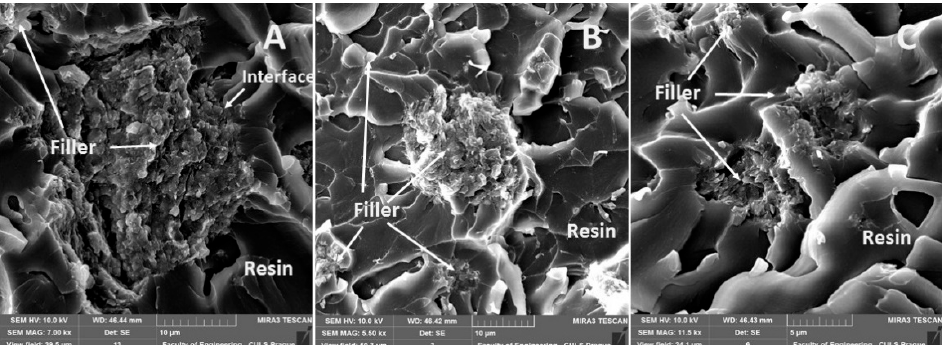
Figure 5. SEM micrographs—static tensile test of composite materials: ( A ) fracture surface of adhesive E5/TFF/100:26/ZR-2 (mag 7.0k×), ( B ) fracture surface of adhesive E5/TFF/100:26/ZR-2 (mag 5.5k×), ( C ) detailed view of fracture surface of adhesive E5/TFF/100:26/ZR-2 (mag 11.5k×).